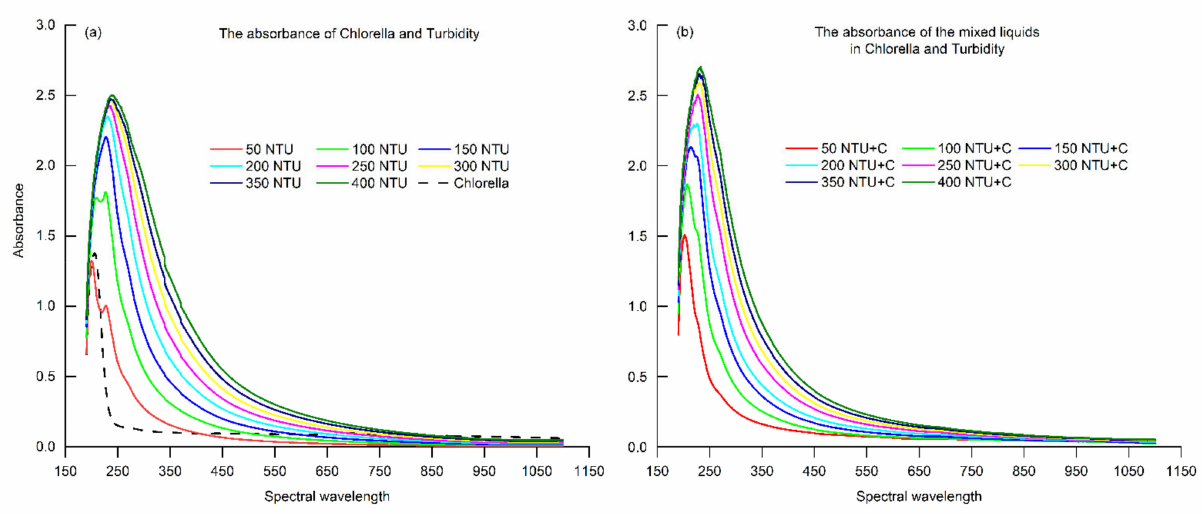
Figure 2. Absorbance of Chlorella and standard turbidity solutions ( a ) and mixtures of Chlorella and standard turbidity solutions ( b